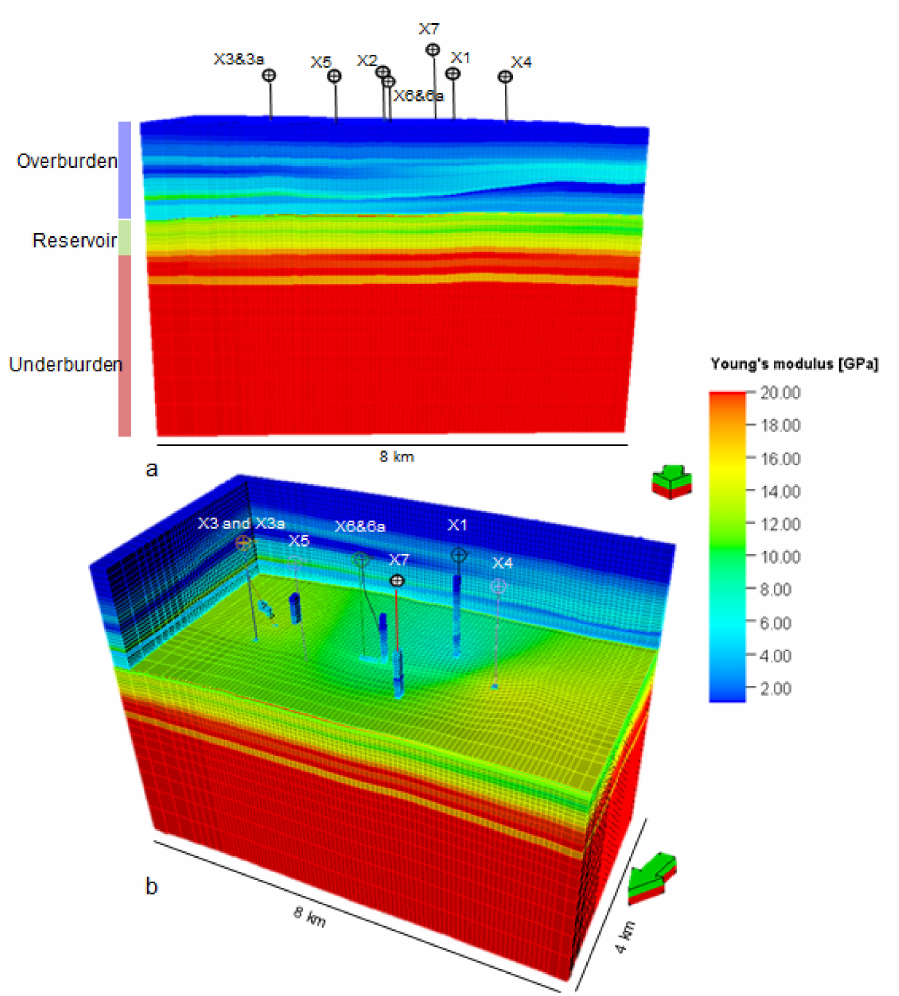
Figure 12. Static Young’s modulus (YME_STA) distribution through upscaled computed log properties (1D MEM) with wells: ( a ) is the cross section of the model for reservoir area as well as overburden and underburden of reservoir area; ( b ) is oblique view of overburden and underburden of reservoir area (arrows point